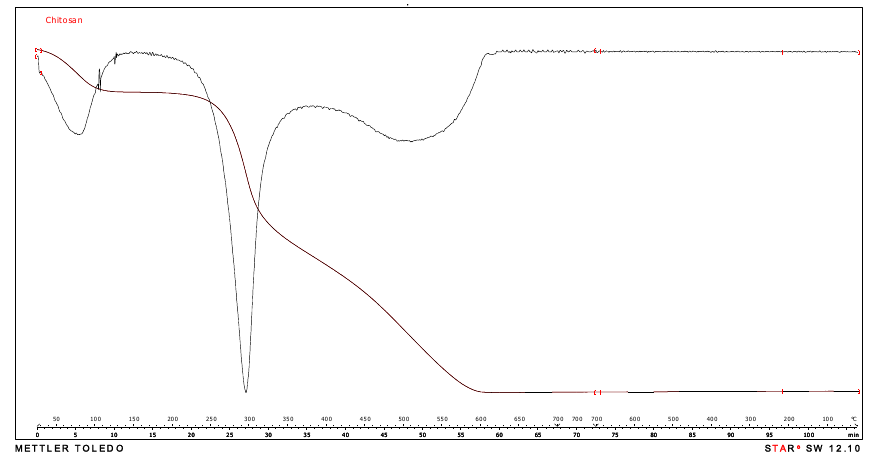
Figure 1. Thermogravimetric analysis (TGA) of the chitosan sample.